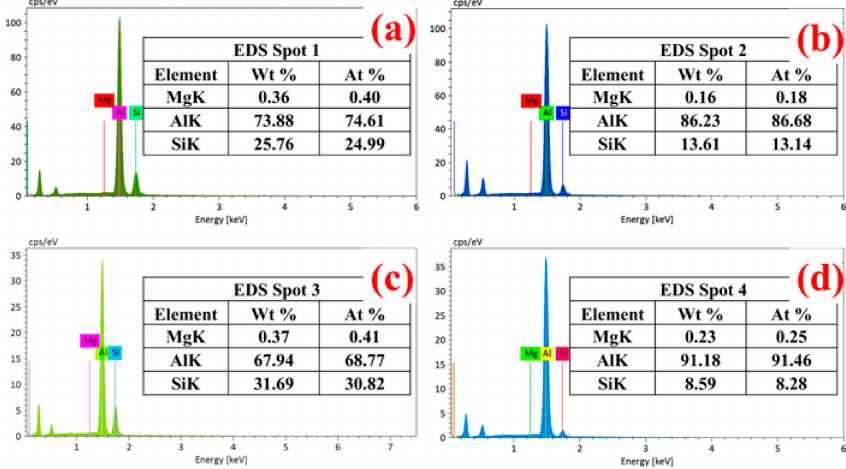
Figure 13. Spot analysis of fracture surface: ( a , b ) Spot 1, Spot 2, and ( c , d ) Spot 3, Spot 4.